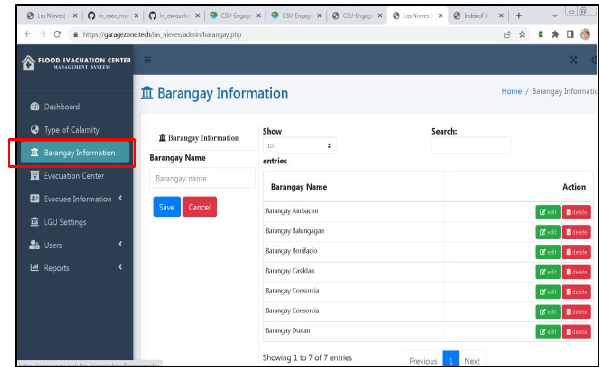
Figure 17. Barangay Information